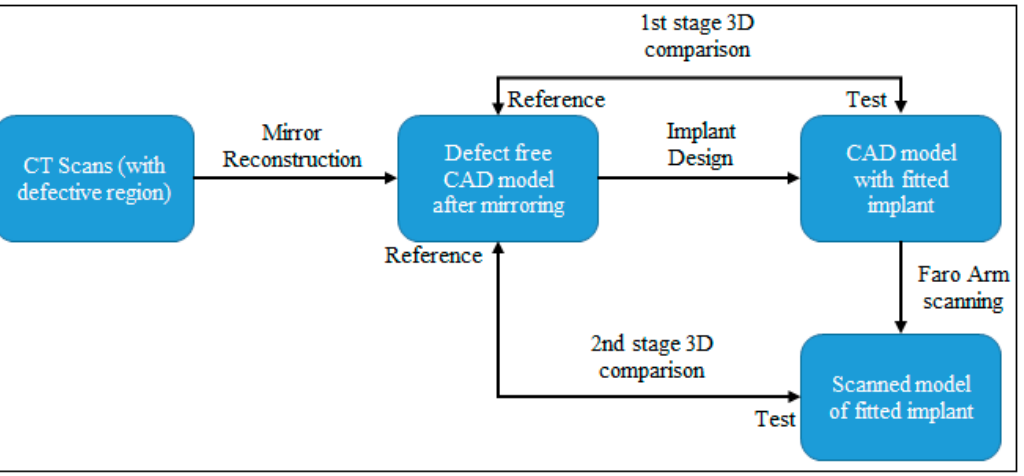
Figure 9. Evaluation of designed implant using comparison approach in Geomagics ® .